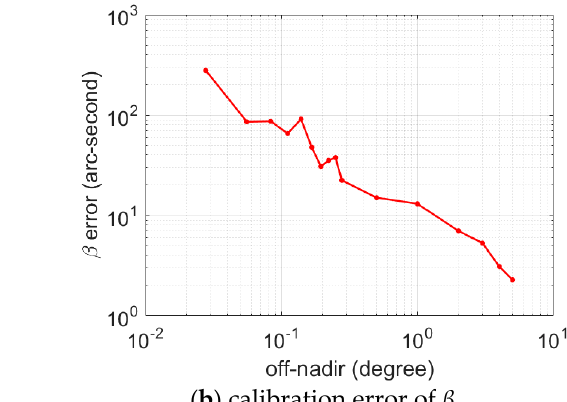
Figure 14. Calibration errors of θ and β with different off-nadir pointing angles. The curves are plotted in logarithmic coordinates.